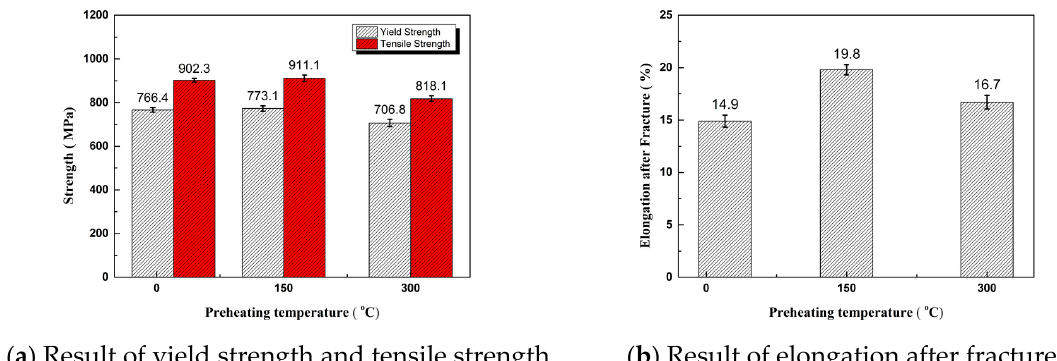
Figure 6. Result of the tensile properties.